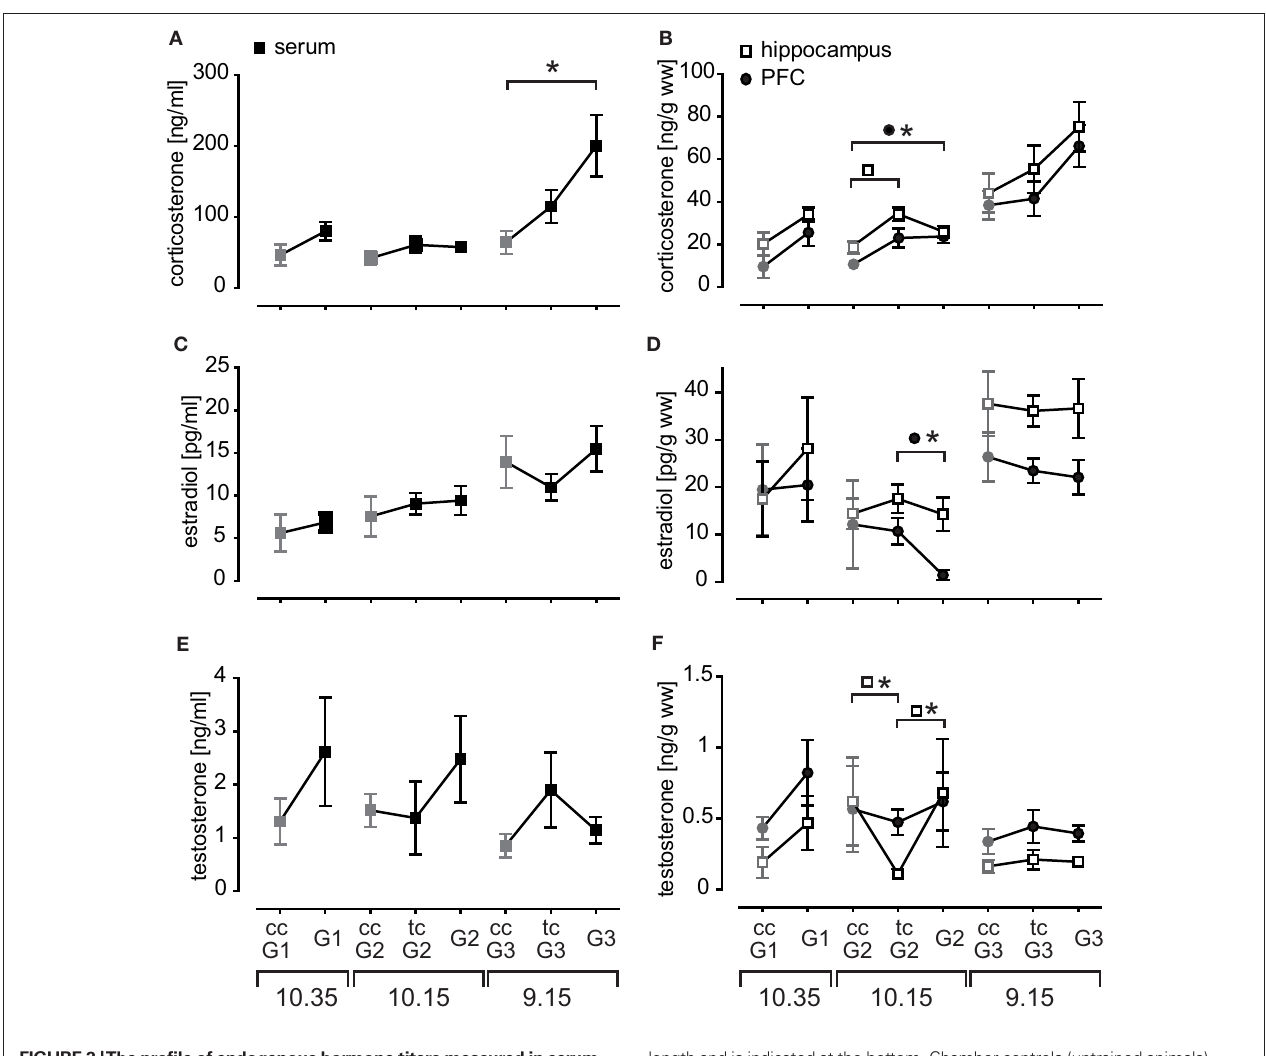
Figure 2 | The profile of endogenous hormone titers measured in serum (left panel) and brain tissue probes (right panel). Given are mean hormone concentrations for (A) corticosterone serum, (B) corticosterone brain tissue, (C) estradiol serum, (D) estradiol brain tissue, (e) testosterone serum, and (F) testosterone brain tissue probes. Time of sacrifice was dependent on session